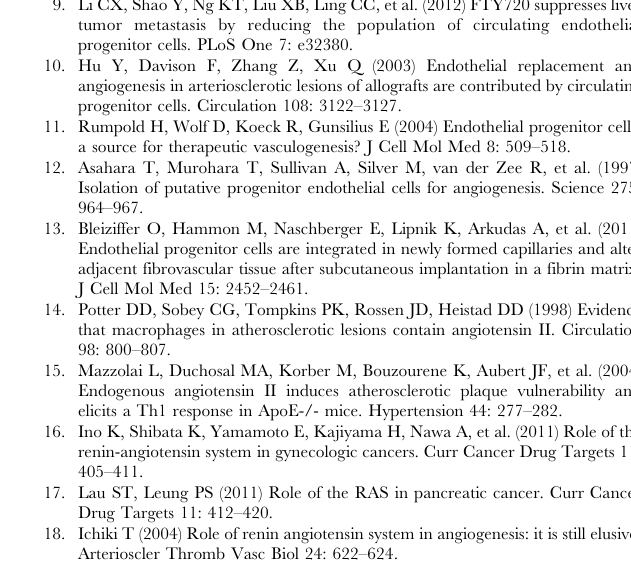
Figure S1 Effect of GGOH on the proliferation of Zol- pretreated EPCs followed by Ang II-stimulation. EPC proliferation was decreased in presence of Zol (75 and 100 m M) and 1 m M Ang II, and could be reversed by 50 m M GGOH. Data are presented as mean 6 SD, n =5. * P , 0.05 vs. Ang II group; &P , 0.05 vs. 75 m M Zol + Ang II group; # P , 0.05 vs. 100 m M Zol + Ang II group. (TIF) Figure S2 Effect of Zol on EPC apoptosis. (A) Represen- tative dot-plots of apoptotic cells cocultured with different concentrations of Zol. (B) Zol did not affect EPC apoptosis. Data are presented as mean 6 SD, n =3, P . 0.05.